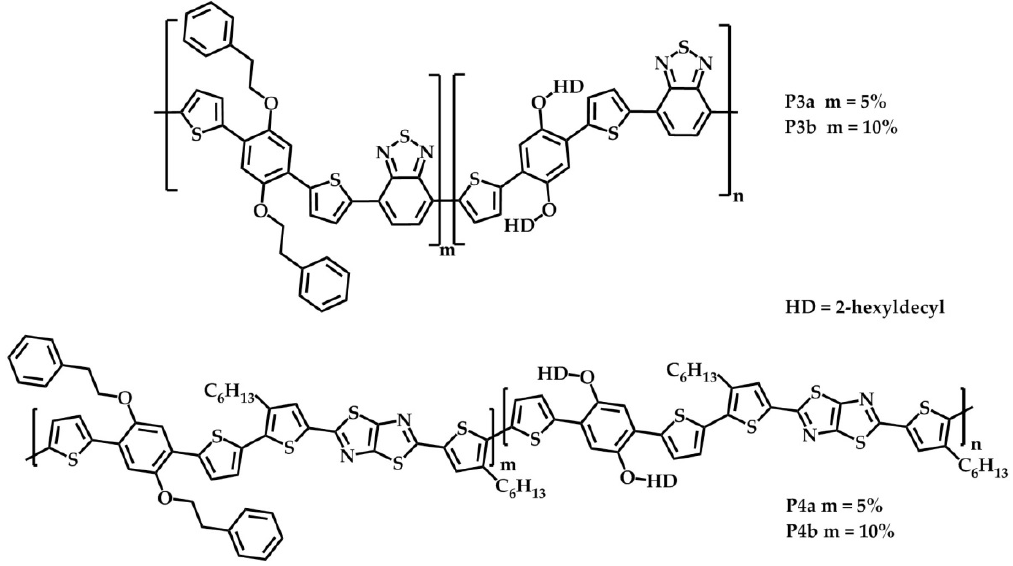
Figure 2. Chemical structures of the investigated statistical copolymers P3a,b and P4a,b .